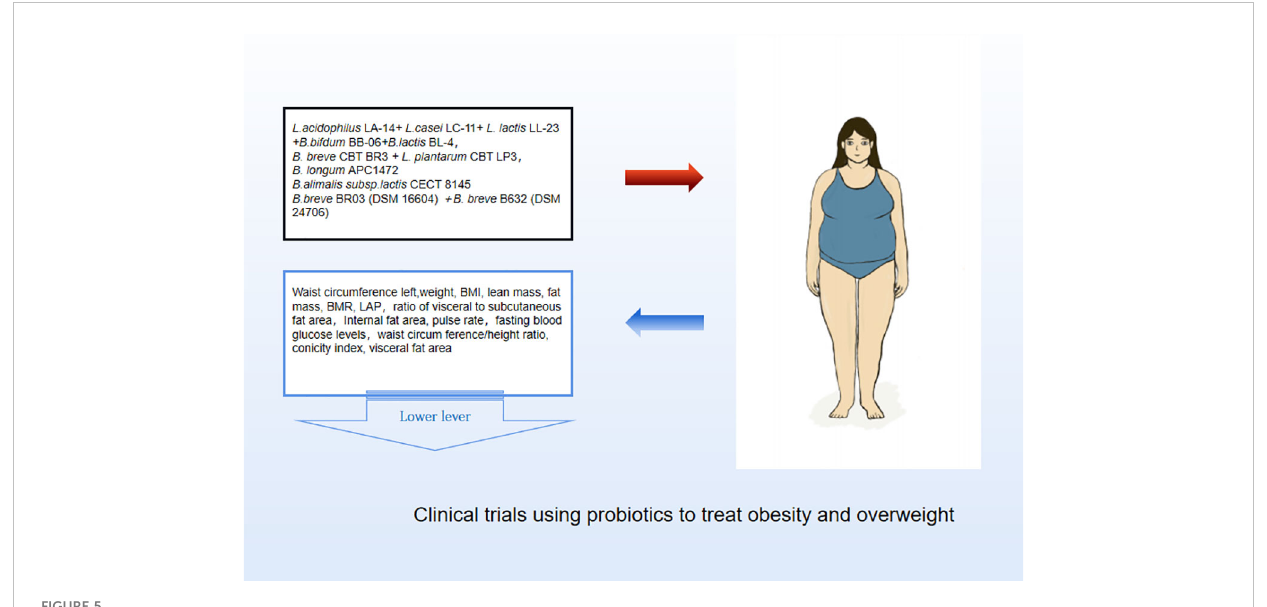
FIGURE 5 Clinical trials using probiotics to treat obesity and